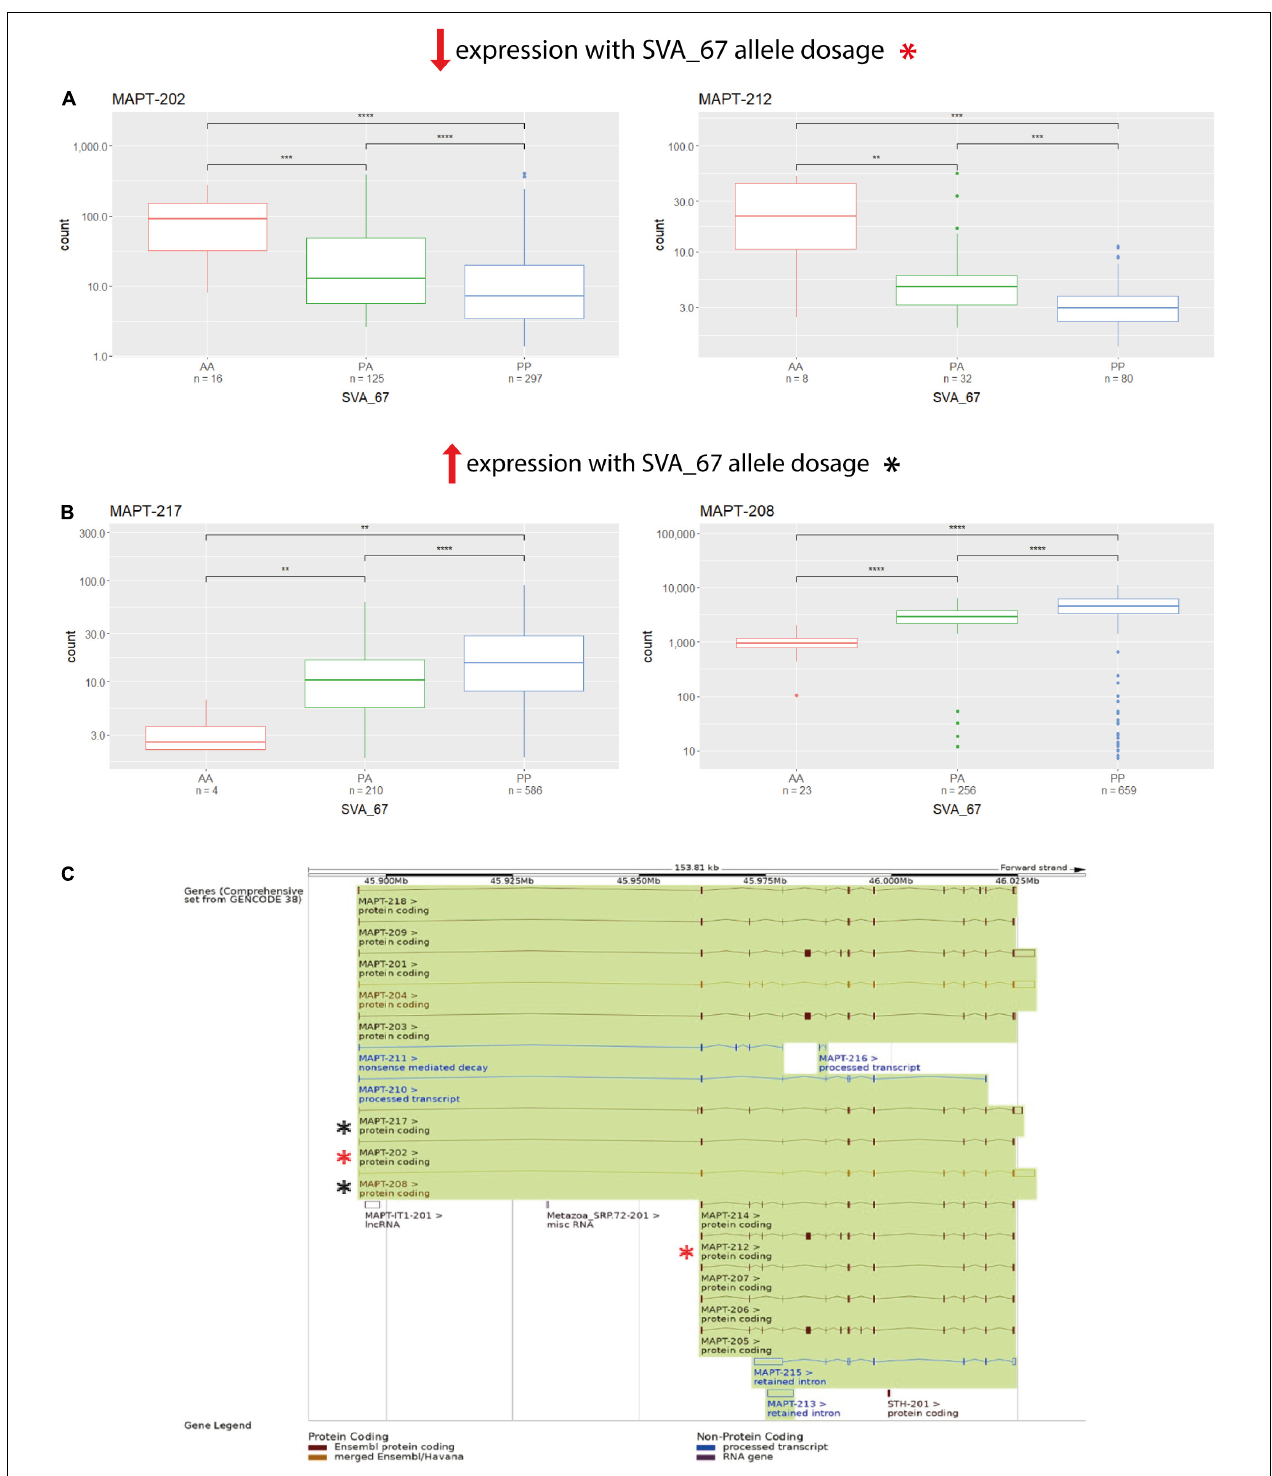
FIGURE 3 | SVA_67 influences expression in an isoform-specific manner. Using the NYGC ALS cohort, isoforms MAPT-202 and MAPT-212 show significantly reduced expression with PP genotype (A) , while the opposite effect is observed for isoforms MAPT-217 and MAPT-208 (B) . Wilcoxon test was applied to demonstrate statistical significance indicated as asterisks. * P ≤ 0.05, ** P ≤ 0.01, *** P ≤ 0.001, **** P ≤ 0.0001, ns > 0.05. (C) Overview of the MAPT gene and all its isoforms as shown on Ensembl. Boxes represent exons, connecting lines introns. Filled boxes show coding sequence, and empty boxes UTRs (untranslated regions). Analysed isoforms of interest in panels (A,B) are highlighted as asterisks (red/black).